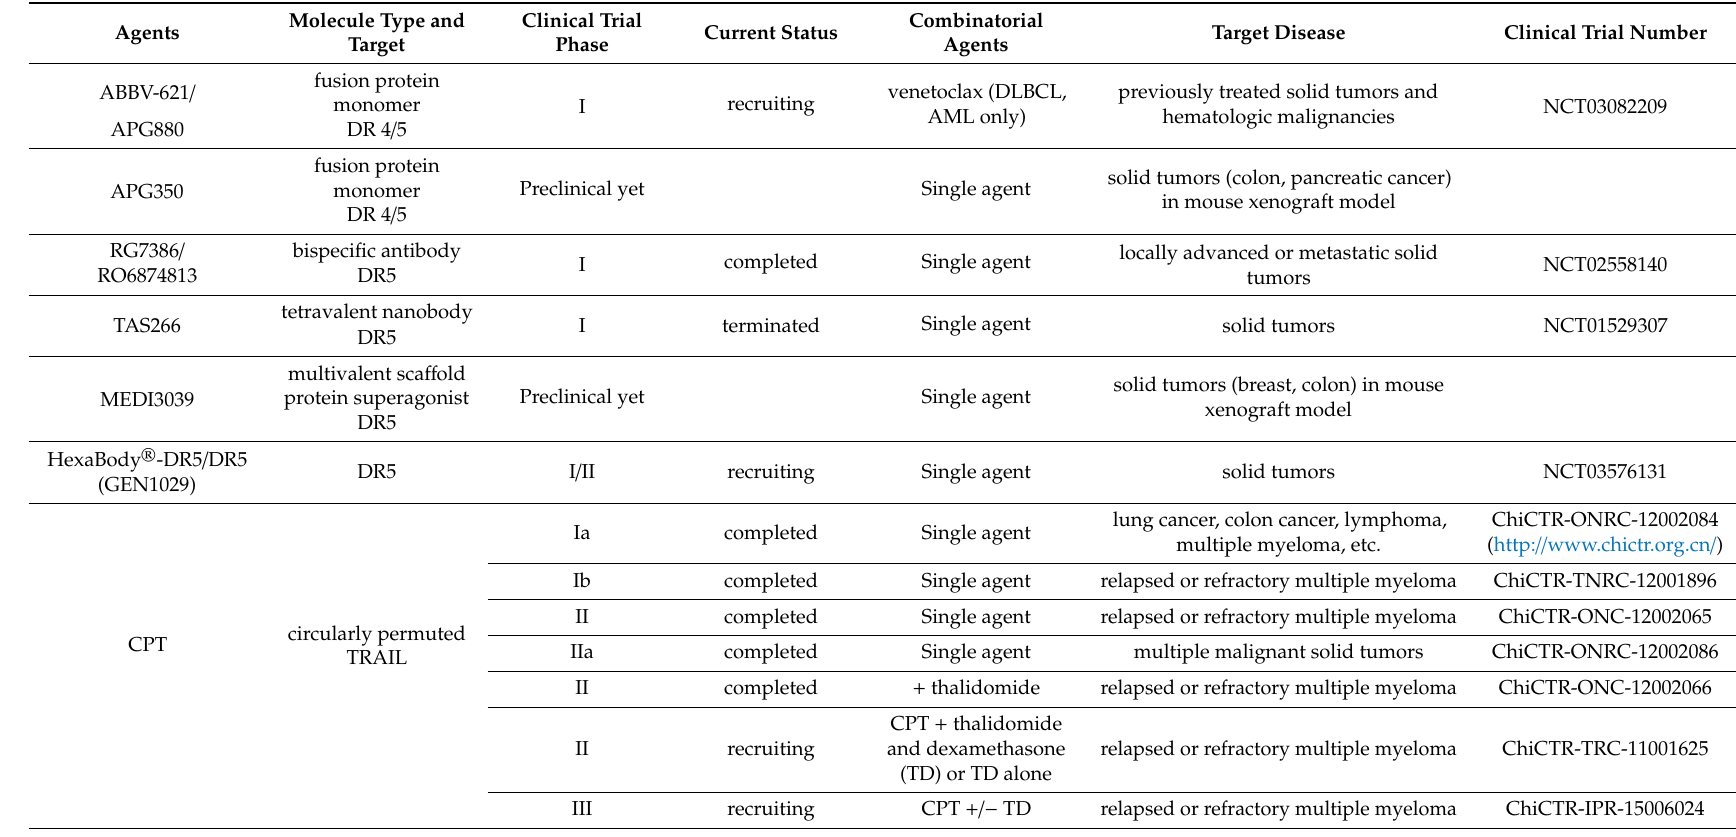
Table 1. Current ongoing clinical trials testing second and third generation death receptor targeted